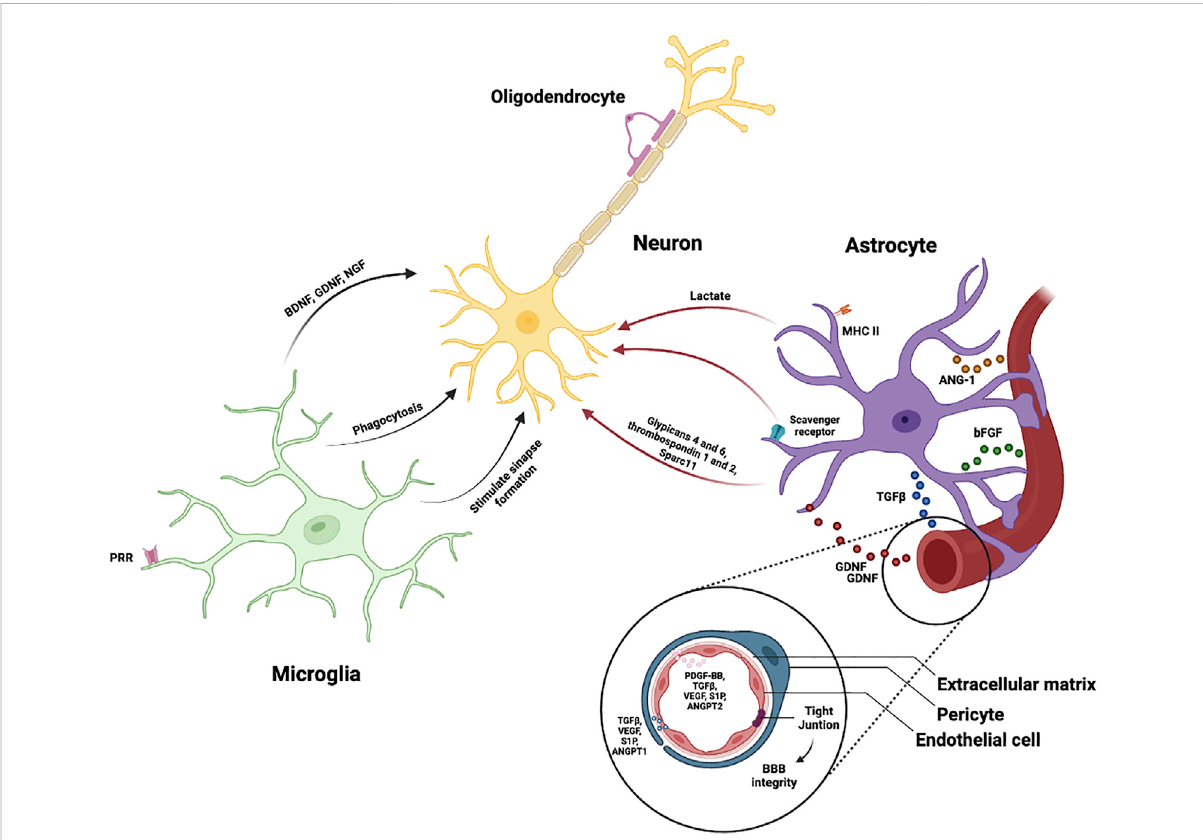
FIGURE 1 Cellular interactions in physiological conditions. All cell types in the brain interact in a complex network to ensure brain function. Microglia stimulate synapse formation, phagocyte neuronal corpses and synapses and generate neuroprotective factors (BDNF, GDNF and NGF). Astrocytes convert glucose in lactate which is then used to satisfy energy requirements of neurons, generate molecules that stimulate neuronal synapse development (Glypicans 4 and 6, thrombospondin 1 and 2, and Sparcl1) and prune synapses and engulf dying cells via scavenger receptors. Astrocytic endfeet participate in the regulation of angiogenesis and in the formation of endothelial cell-to-cell junctions by releasing soluble factors (GDNF, TGF β , bFGF, ANG-1). Pericytes in fl uence angiogenesis, extracellular matrix production, BBB function, wound healing, regulate immune